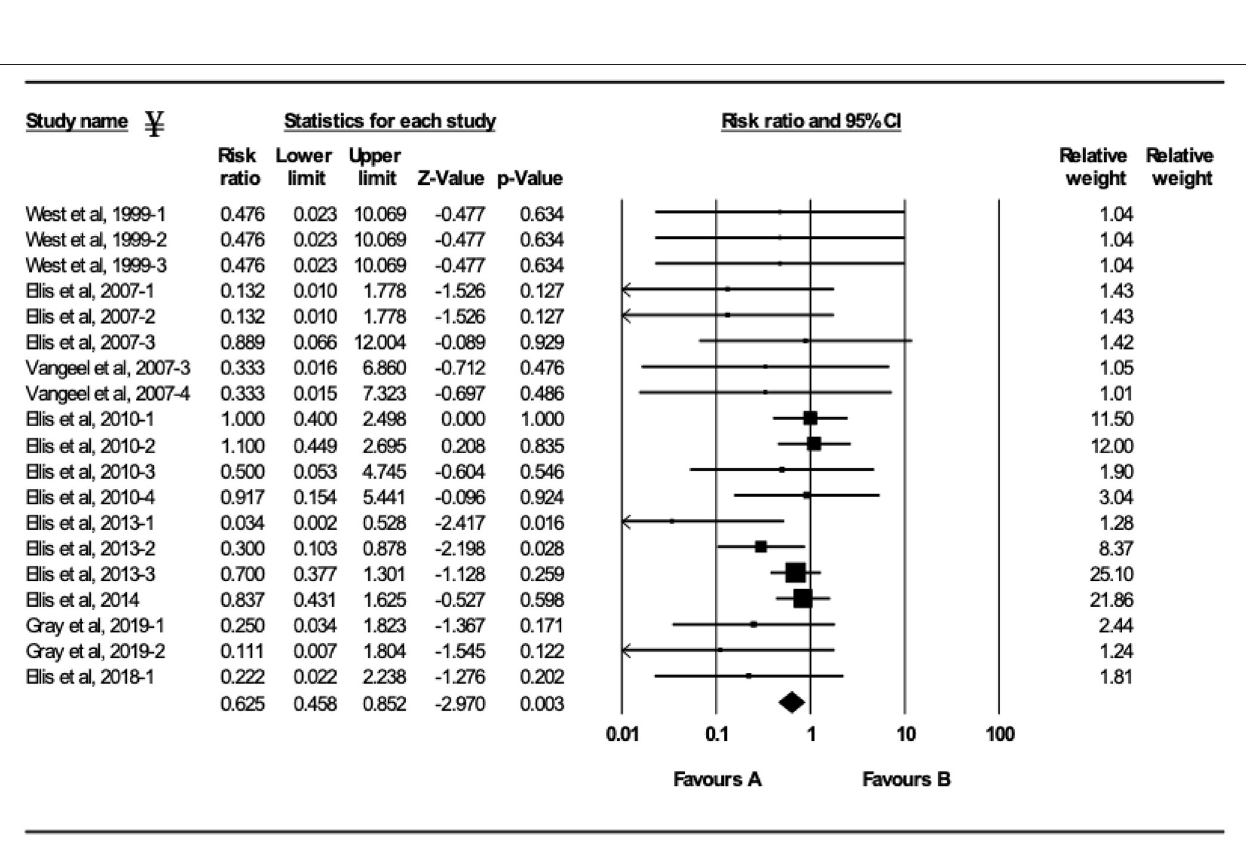
FIGURE 4 | Forest plot of mortality risk ratios from experimental BRSV challenge trials that evaluated MLV BRSV vaccines. U Only trials with a significant mortality effect between vaccinated and controls calves are shown by the meta-analysis software in the forest plot. Heterogeneity stats: Q -Value: 16.04, df ( Q ): 18 p : 0.59 I 2 : 0.